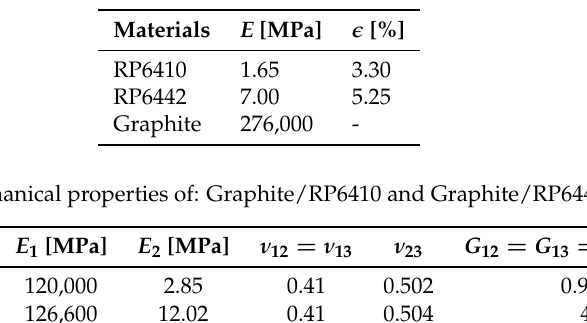
Table 2. Mechanical properties of laminates with high stiffness ratio [64].